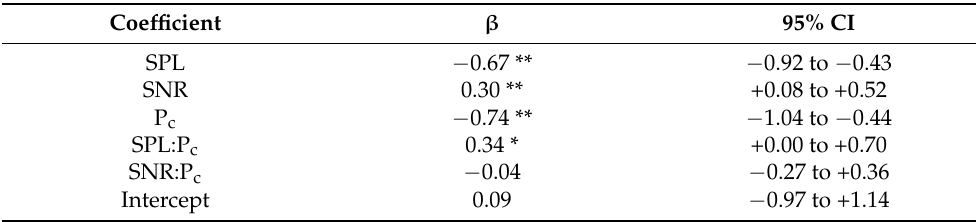
Table 3. Regression coefficients ( β ) with 95% CIs for predicting volume control changes. The predictors were ambient sound environment characteristics (SPL and SNR, scaled and centered) and listening program ( n = 1026). The default listening program was used for baseline contrast. Coefficient β 95% CI SPL − 0.67 ** − 0.92 to − 0.43 SNR 0.30 ** +0.08 to +0.52 P c − 0.74 ** − 1.04 to − 0.44 SPL:P c 0.34 * +0.00 to +0.70 SNR:P c − 0.04 − 0.27 to +0.36 Intercept 0.09 − 0.97 to